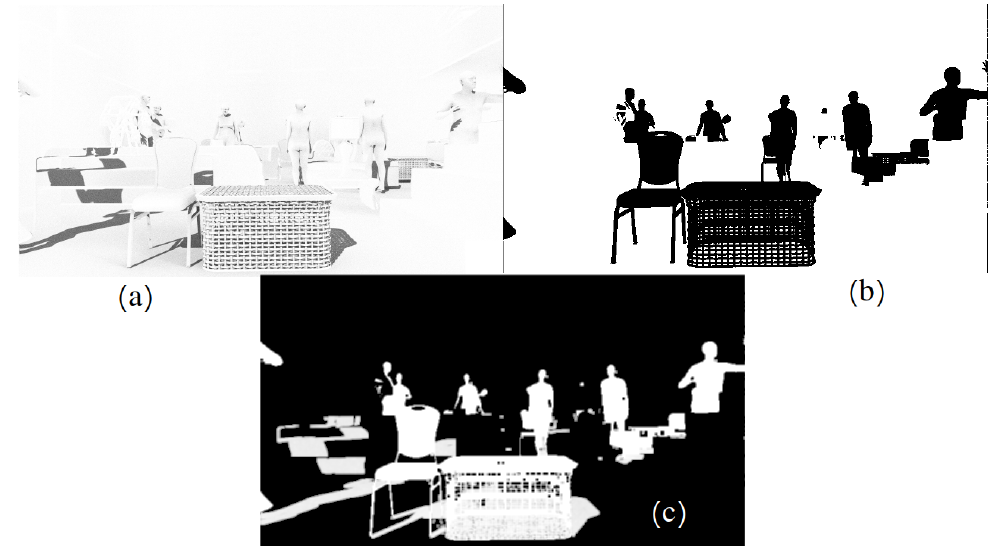
Figure 12. Rendered image ( a ), object mask ( b ) and objects cutout ( c ).